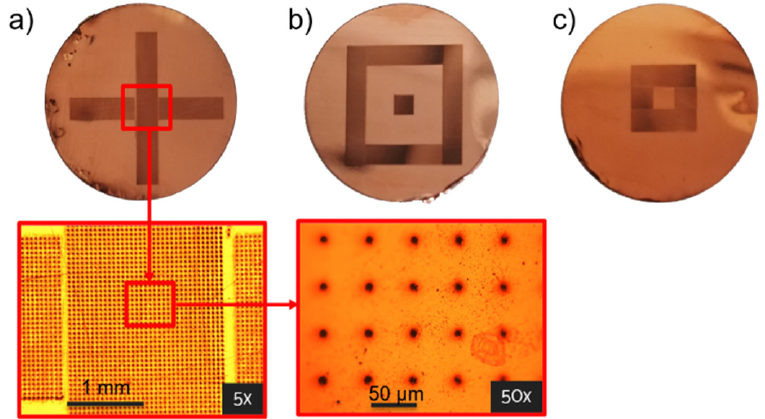
Figure 4. Pore cross section. θ represents the taper angle. In Figure 5 the bottom surfaces of Cu-Kapton-Cu (CKC) multilayer membranes are shown. In the inset of Figure 4, the pores distribution is highlighted at two different magnifications.